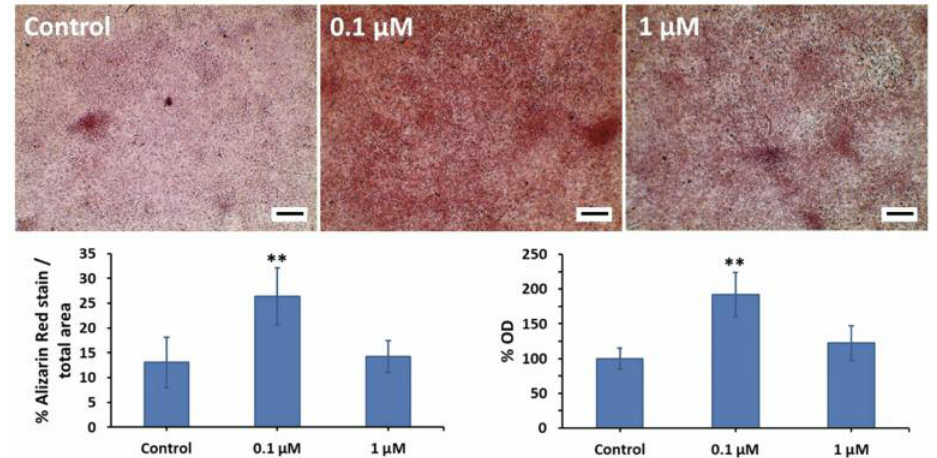
Figure 4. Cd e ff ects on mineralization process. Images show osteoblast cultures stained with Alizarin Red S Staining Quantification assay. The graphs represent the quantification of mineralization performed by image analysis (left) and spectrophotometry (right), where the results are expressed as the percentage of stained area and the percentage of OD (assuming control cell absorbance as 100%), respectively. ** indicate significant ( p < 0.01) di ff erence compared to